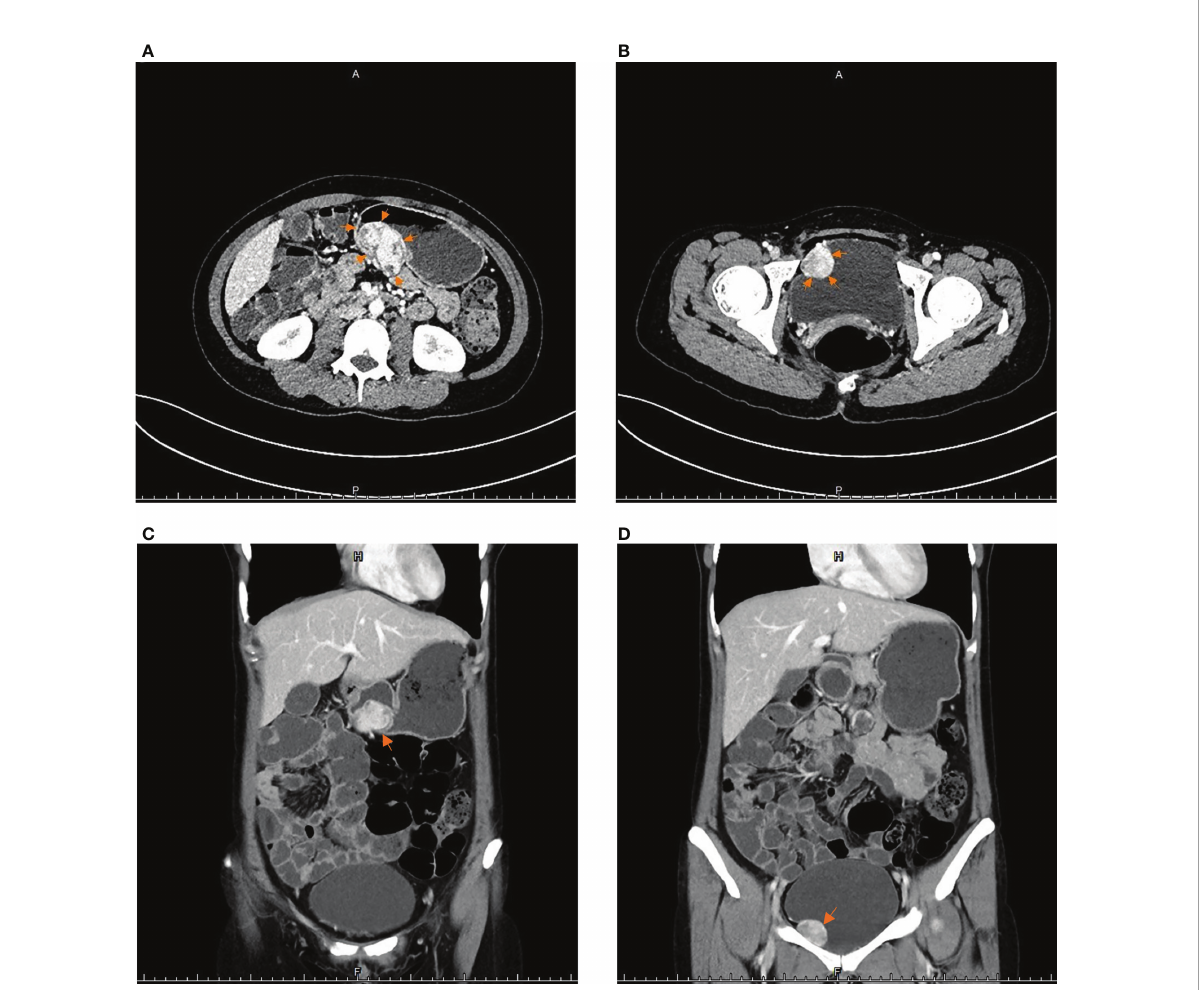
FIGURE 1 The imaging results of contrast-enhanced CT scans of the abdomen and pelvis: (A, C) The arrows point to a soft tissue mass approximately 33 mm×54 mm in the posterior wall of the gastric body. (B, D) The arrows point to a protrusion into the right wall of bladder, approximately 26 mm×29 mm in size of round